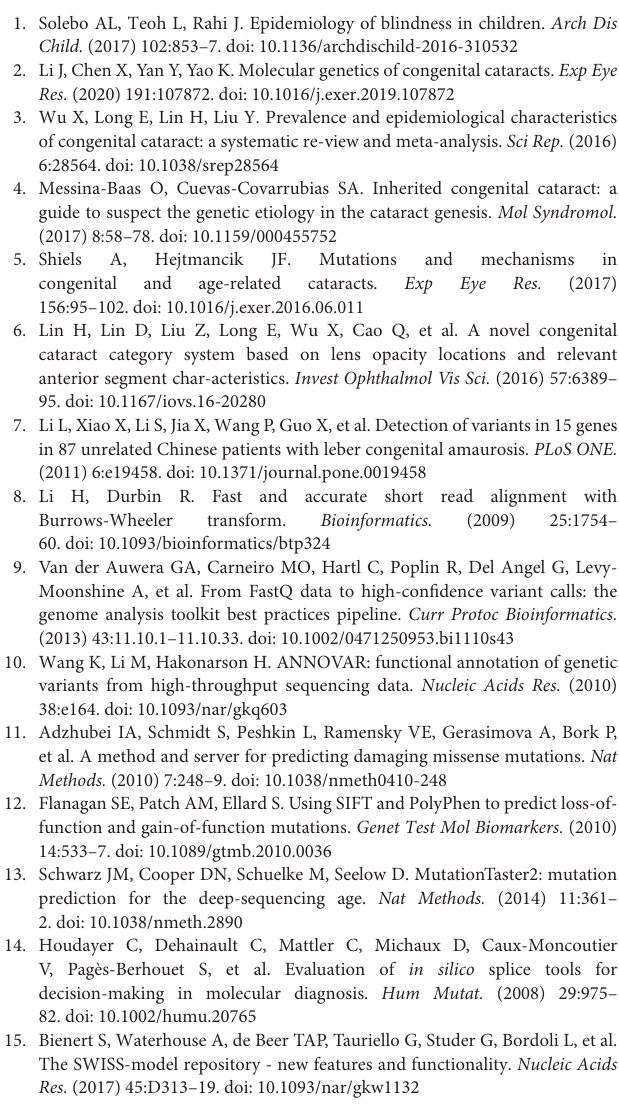
Supplementary Figure 1 | Predicting results of the ProtScale program. (A) The predicting result of the hydrophobicity of wild-type β B2-crystallin; (B) The